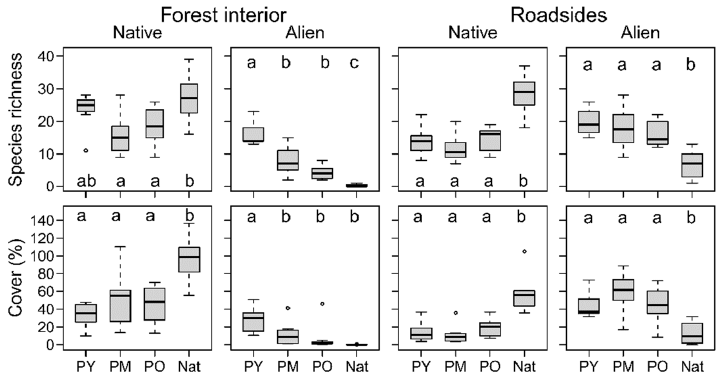
Figure 4. Mean transect-based species richness and cover values (shrub and herb layer values were summed up) of native and alien species in forest interiors and roadsides of the different plantation age classes and of the natural forest (PY = young plantation, PM = medium-aged plantation, PO = old to mature plantation, Nat = Natural forest). For plantation age classes and roadsides n = 8 transects per forest type were considered. For natural forest interiors, n = 11 transects were sampled. Different letters indicate significant differences among plantation age classes and the natural forest respectively based on linear mixed model